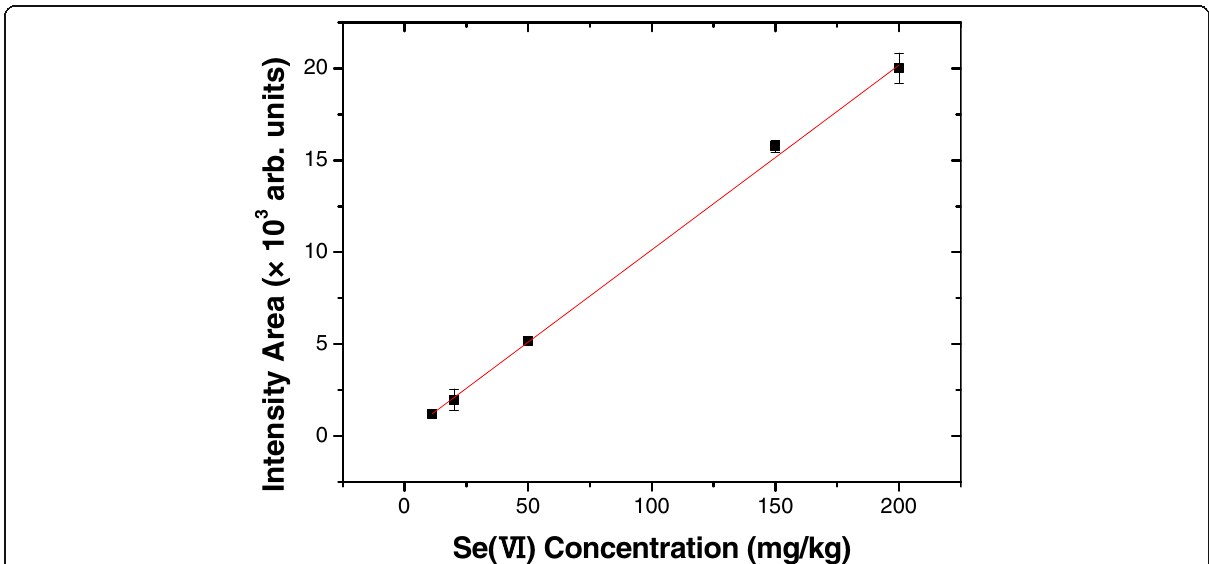
Fig. 4 Calibration curve of Se (VI) from LIBS analysis of the membrane filters. The filled squares represent the experimental values, and the red line is a linear fit of them ( y = a + bx , with a = − 6.85 ± 5.05, b = 10.55 ± 0.06, and R 2 =